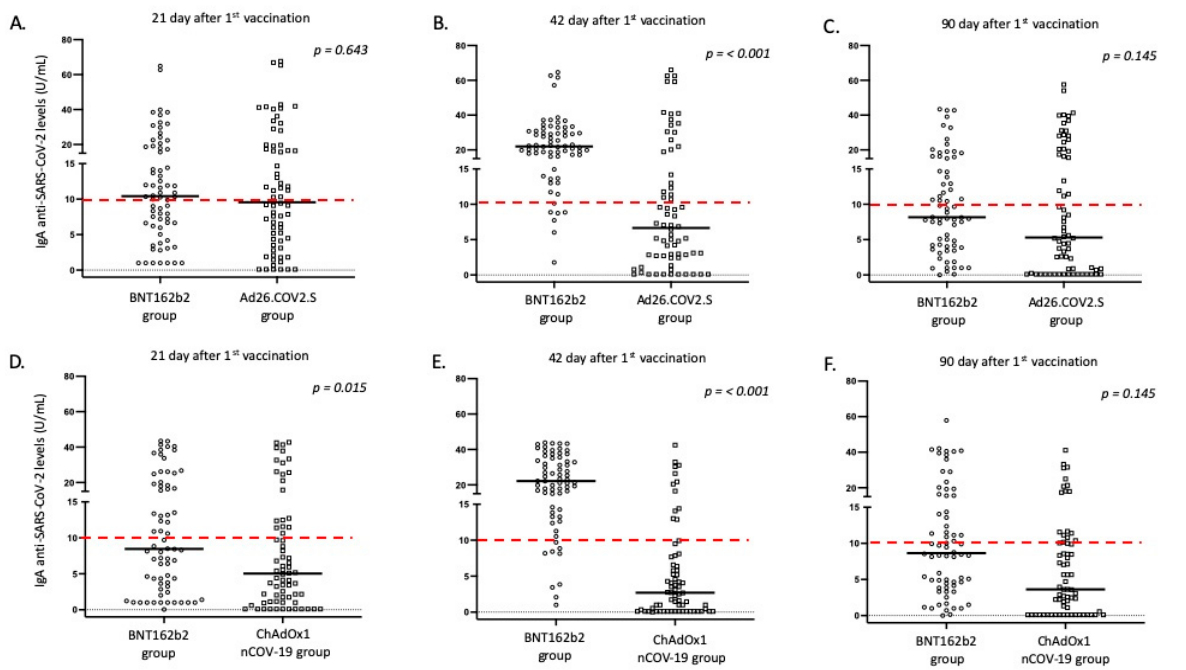
Figure 2. IgA anti SARS-CoV-2 responses in the study participants according to vaccine platform: ( A , D ) day 21, ( B , E ) day 42, and ( C , F ) day 90. Black lines indicate median values, and red dotted lines represent the cutoff of positive anti-SARS-CoV-2 IgA (10 U/mL) antibodies.